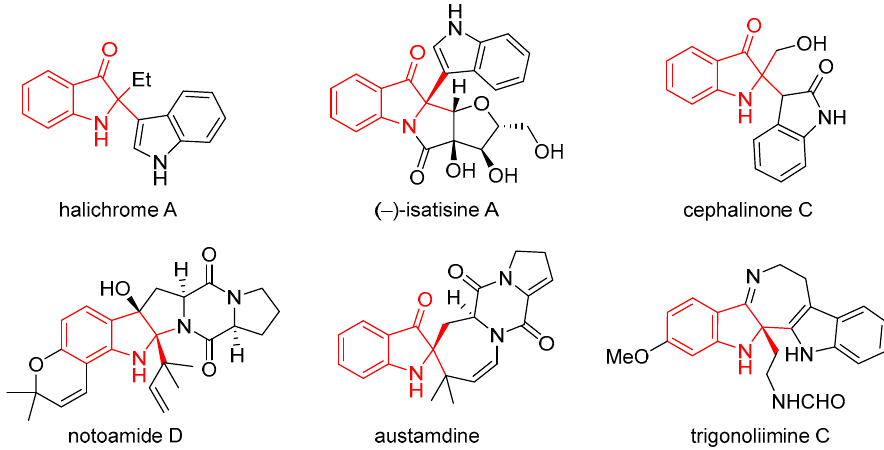
Figure 1. Representative bioactive natural products with 2,2-disubstituted indolin-3-one motif.